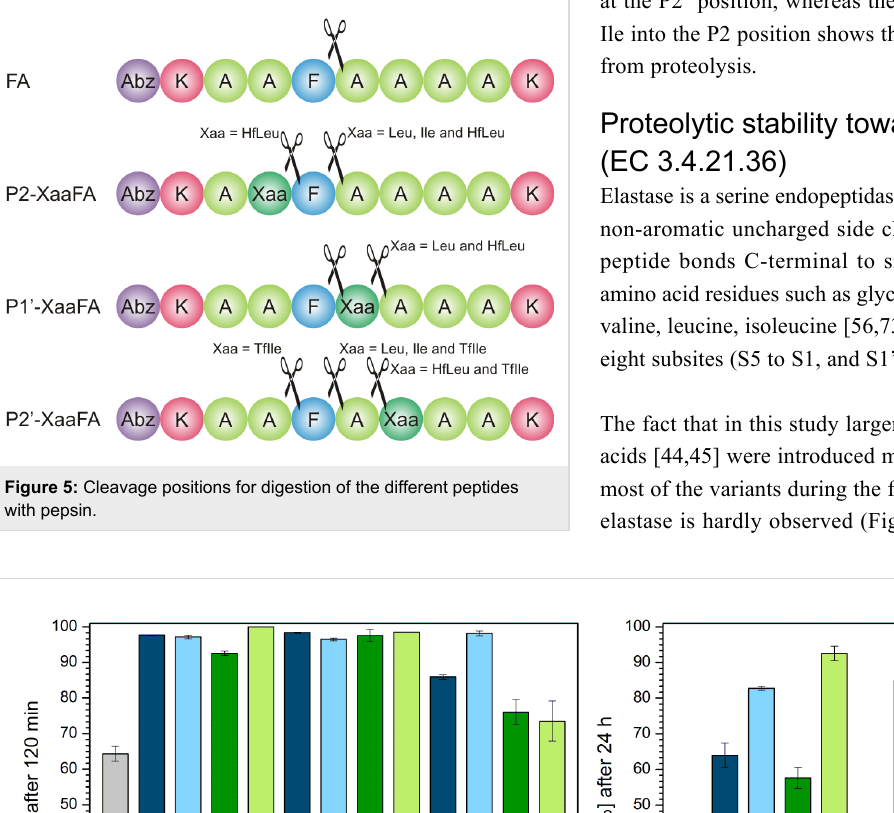
three fluorine atoms into Ile slows down proteolysis, although both peptides are completely digested after 24